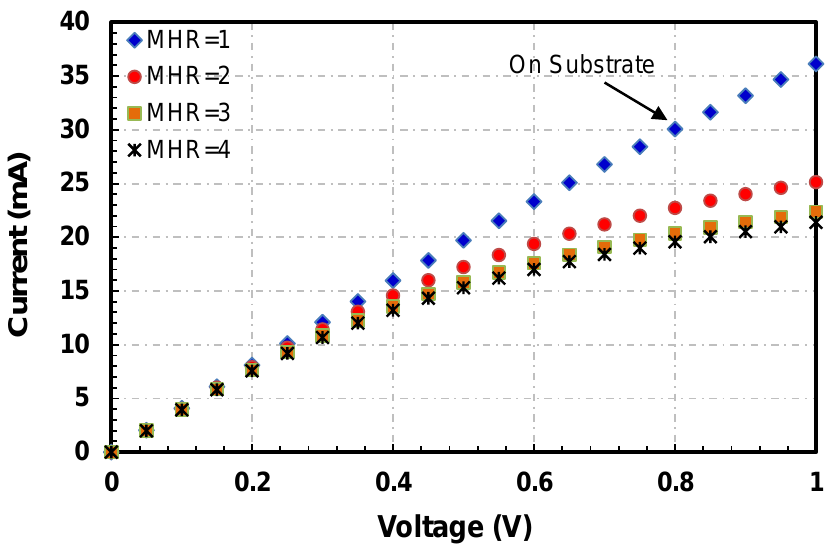
Figure 10. I – -V curves of sensors FS2, FS4, FS6 and FS8 having circular membranes: For MHR 1 (actually on substrate as membrane did not get etched), the I – V curve is almost linear indicating negligible change in sensor’s resistance. With increasing MHR , however, sensors’ Joule heating and resistances increase significantly.